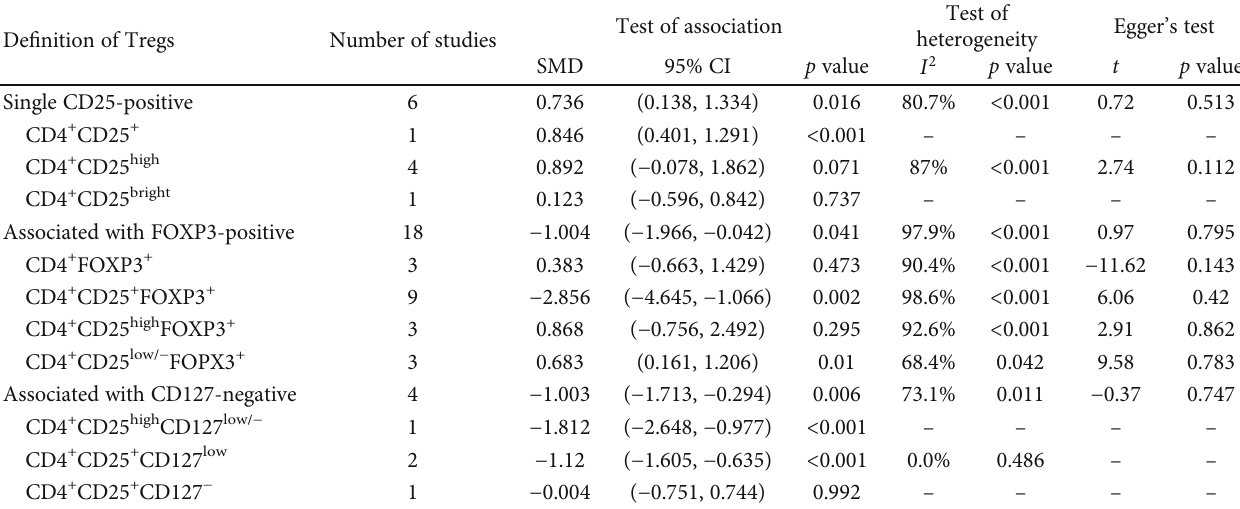
Table 2: Subgroup analysis based on di ff erent de fi nitions of Tregs in PB of patients with AS. De fi nition of Tregs